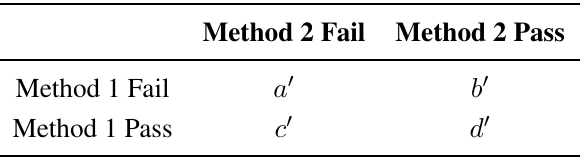
Table 1. McNemar’s 2 × 2 classification